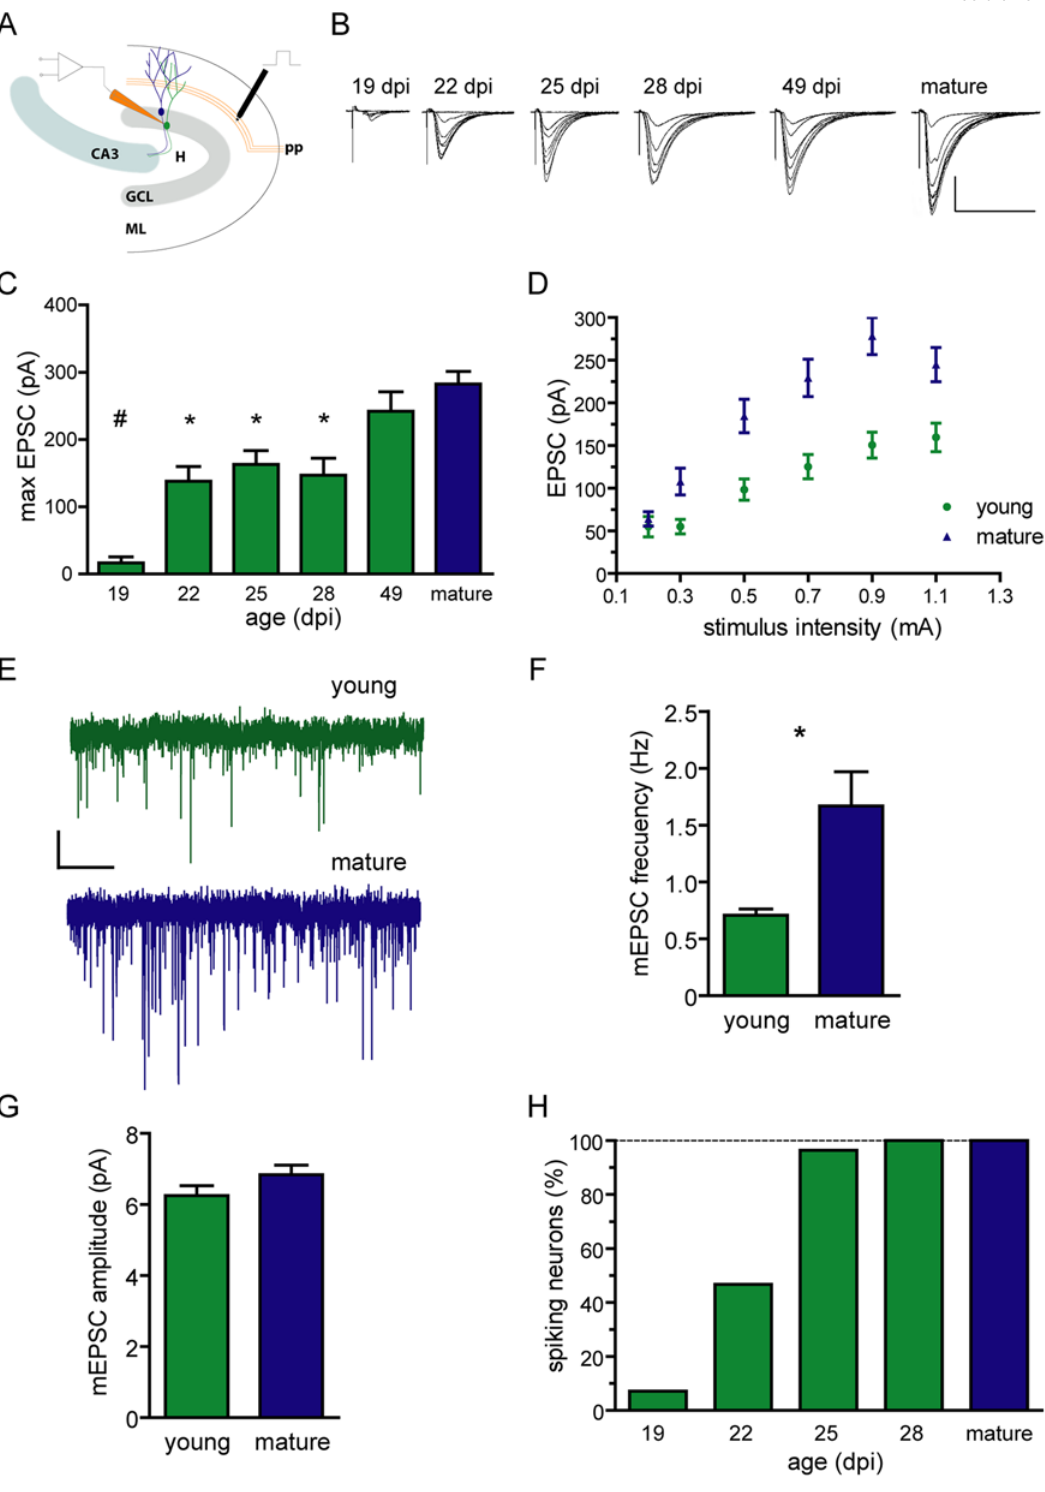
Figure2. Spikesinyoungneuronselicitedbyweakglutamatergicinputs. (A) Illustrationdepictingelectrophysiological recordings ofpostsynaptic responses in acute hippocampal slices. Stimulation was performed in the medial perforant path (pp), and whole-cell recordings were obtained in young (green) or mature (blue) granule cells. GCL, granule cell layer; ML, molecular layer; H, hilus. (B) Example traces of EPSCs evoked by increasing stimulus strength (0.2–1 mA, 50 m s) obtained from DGCs of different developmental stages (shown on the top). Each trace is an average of five epochs. Scale bars: 100 pA, 50 ms. (C) Maximal peak EPSCamplitude foryoungand matureDGCs.( # ) denotes p , 0.001,and (*) denotes p , 0.05 when compared tomature, as analyzed by ANOVA followed by a Bonferroni’s post-hoc comparison,with N=9 (19 dpi), 9 (22 dpi),14 (25 dpi), 10 (28 dpi), 10 (49 dpi) and 41 (mature). (D) Peak EPSC amplitude vs. stimulus intensity in young (21–29 dpi) and mature DGCs. Two-way ANOVA revealed a significant effect of both neuronal age and stimulus intensity ( p , 0.0001 for both), with N=27 for both groups. (E) Representative traces of miniature postsynaptic currents obtained in presence of 0.5 m M tetrodotoxin. Scale bars: 2.5 pA, 5 s. (F, G) Frequency and amplitude of mEPSCs. (*) denotes p =0.016; for amplitude p =0.14; N=8 for both. (H) Fraction of spiking neurons as a function of age. Spiking was measured in whole-cell current clamp and was elicited by stimuli that rendered maximal EPSC amplitudes, with N=14 (19 dpi), 15 (22 dpi), 28 (25 dpi), 21 (28 dpi) and 59 (mature). doi:10.1371/journal.pone.0005320.g002 PLoS ONE |